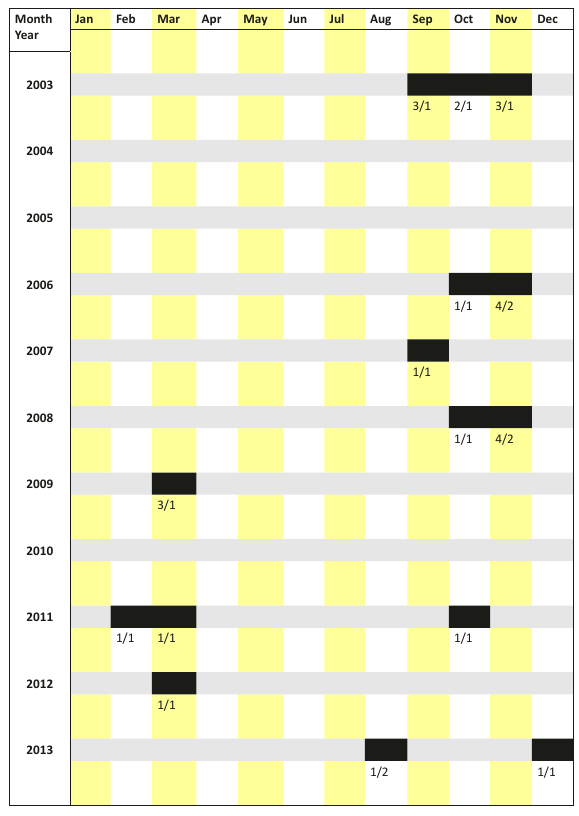
Fig 1. Occurrence of Euthalia aconthea in the Study Area Figures below the bar x/y under the month indicate: x = Number of days Euthalia aconthea was spotted in the month. y = Maximum number of individuals seen on any day in the